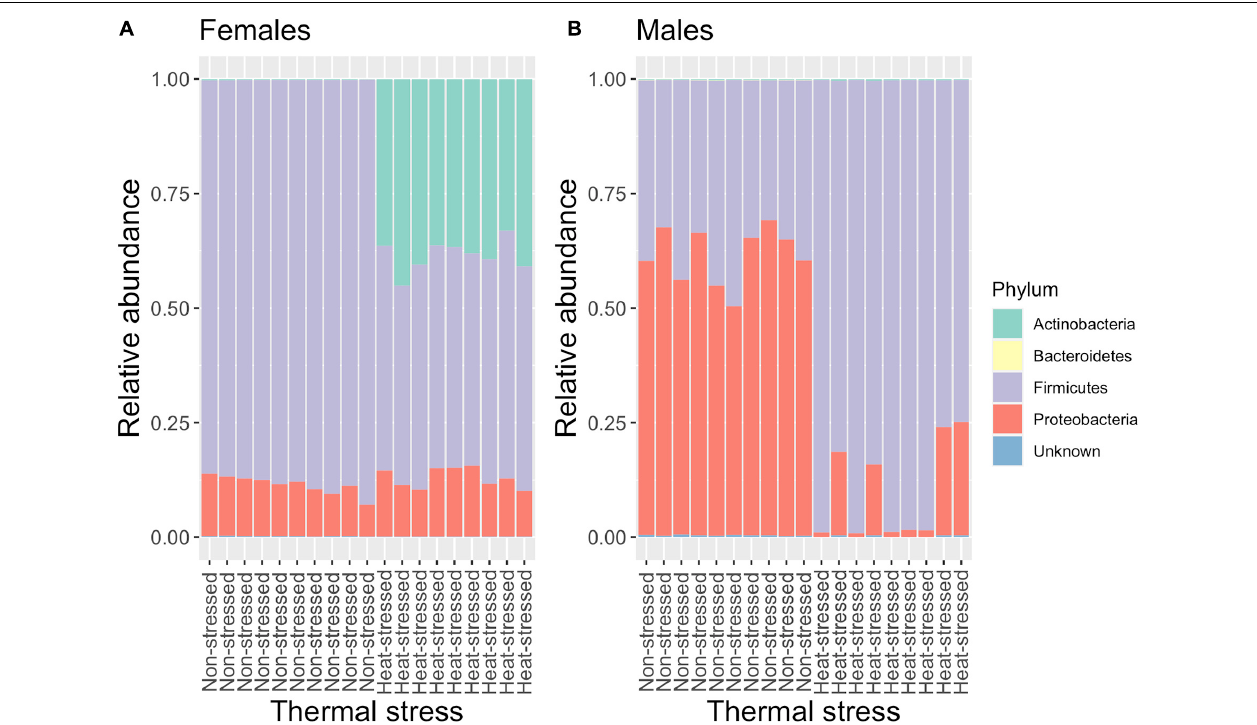
FIGURE 2 | Relative abundance of the bacterial composition (phylum) of the gut microbiota of non-stressed (flies exposed to 21 ◦ C) and heat-stressed (flies exposed to 34 ◦ C for 1 h) females (A) and males (B) of Drosophila subobscura . Each color represents a bacterial